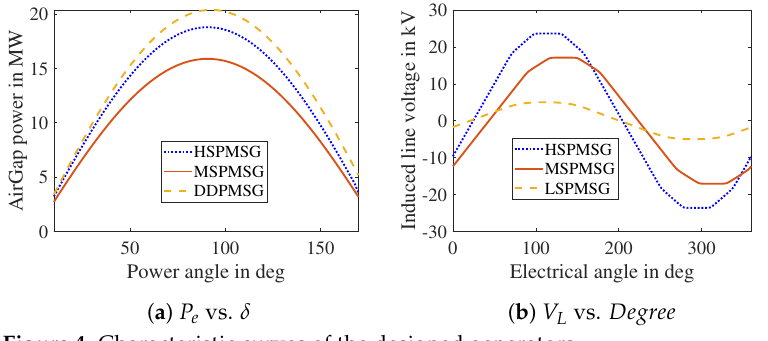
Figure 4. Characteristic curves of the designed